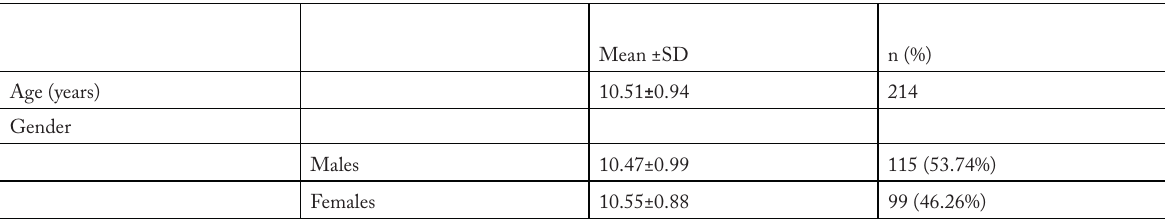
Table 1. Descriptive statistics of the study participants ( n = 214).